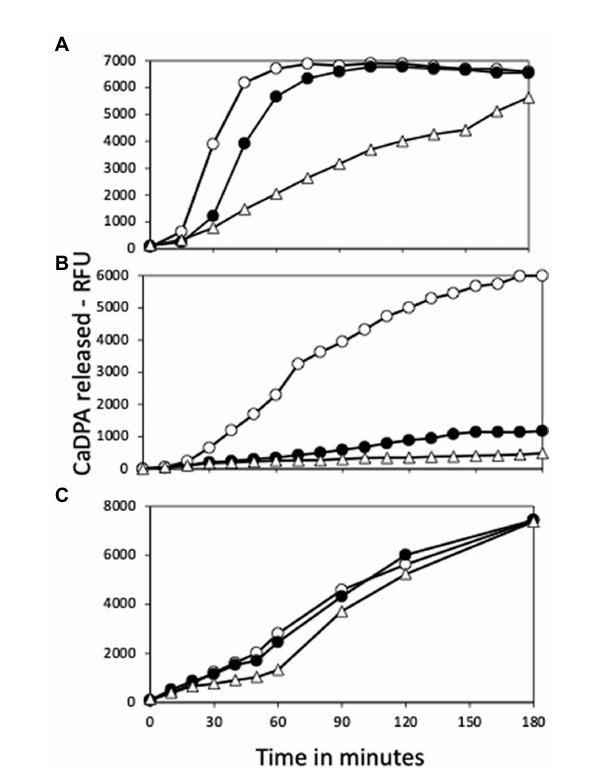
FIGURE 6 L-Valine germination of (A) PS832 (wt), (B) PS4487 ( ydfS ) and (C) PS4488 ( yetF ) spores after various heat activation times. Spores of various strains at an OD 600 of 1 were incubated in water at 80 ° C, and at various times aliquots were removed and cooled and germinated with L-valine and germination followed in a plate reader measuring fluorescence of released DPA in arbitrary units (AU) as described in Methods. All values shown are averages of duplicate determinations in two experiments. The symbols for the various heating times are: 0 min – ○ ; 30 min – ● ; 60 min – △ ; 90 min – ▲ ; 120 min – □ ; and 150 min – ■